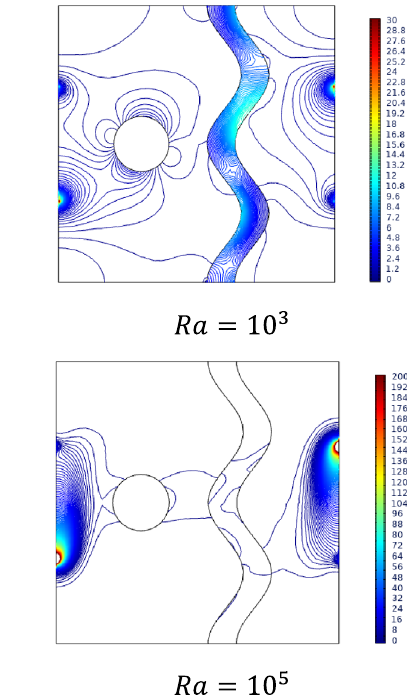
Figure 17. Variations of the general entropy with various Rayleigh number Ra at Ha 0.2 , and ω 0.02 , ε φ = =